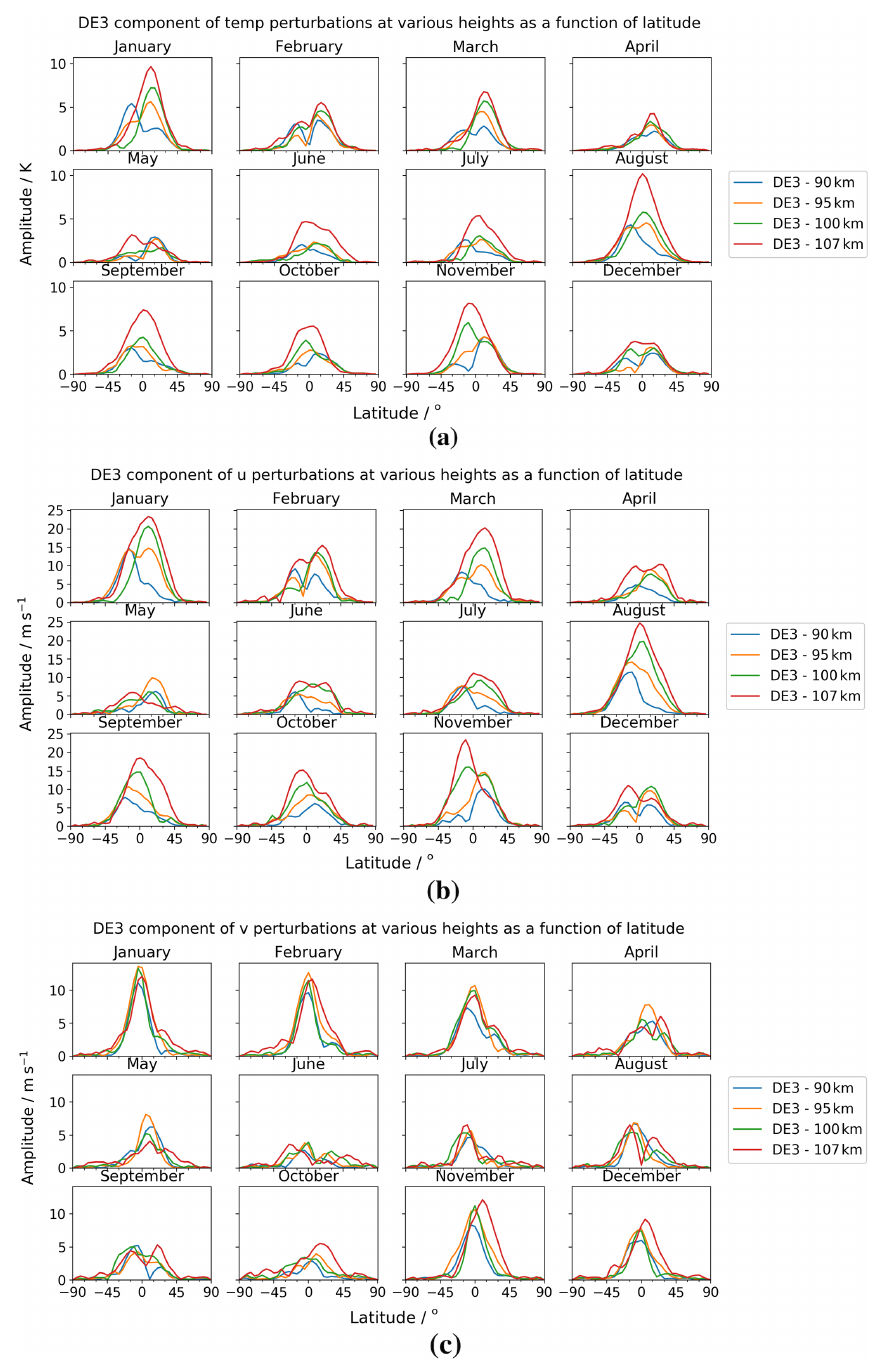
Figure 15. Latitude–amplitude plot of DE3 tidal amplitudes at various heights across the year for (a) temperature, (b) zonal ( u ) winds, and (c) meridional ( v )